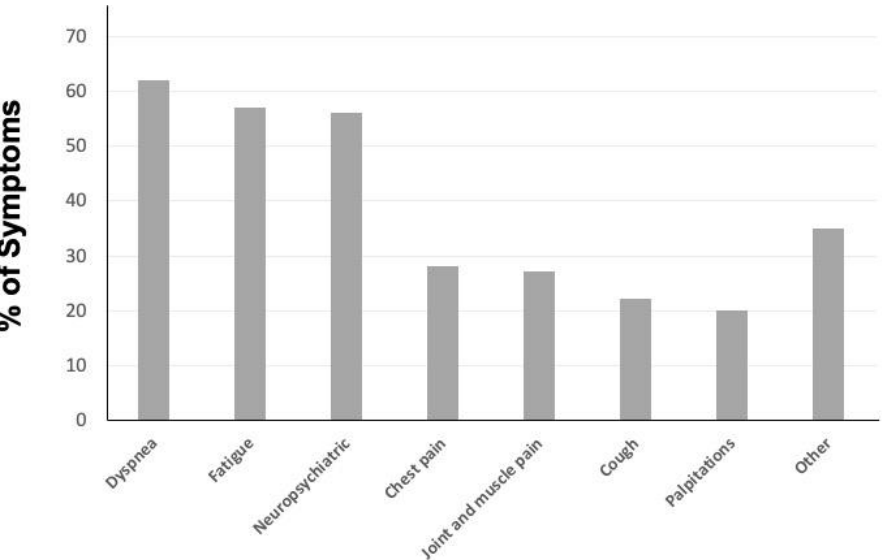
Figure 1. Percentage of symptoms reported in the long COVID group.